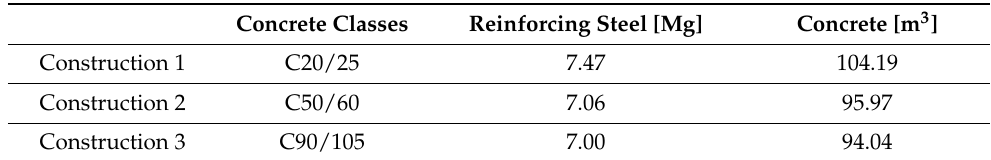
Table 3. Consumption of concrete and reinforcing steel in the analyzed reinforced concrete structure depending on the adopted concrete